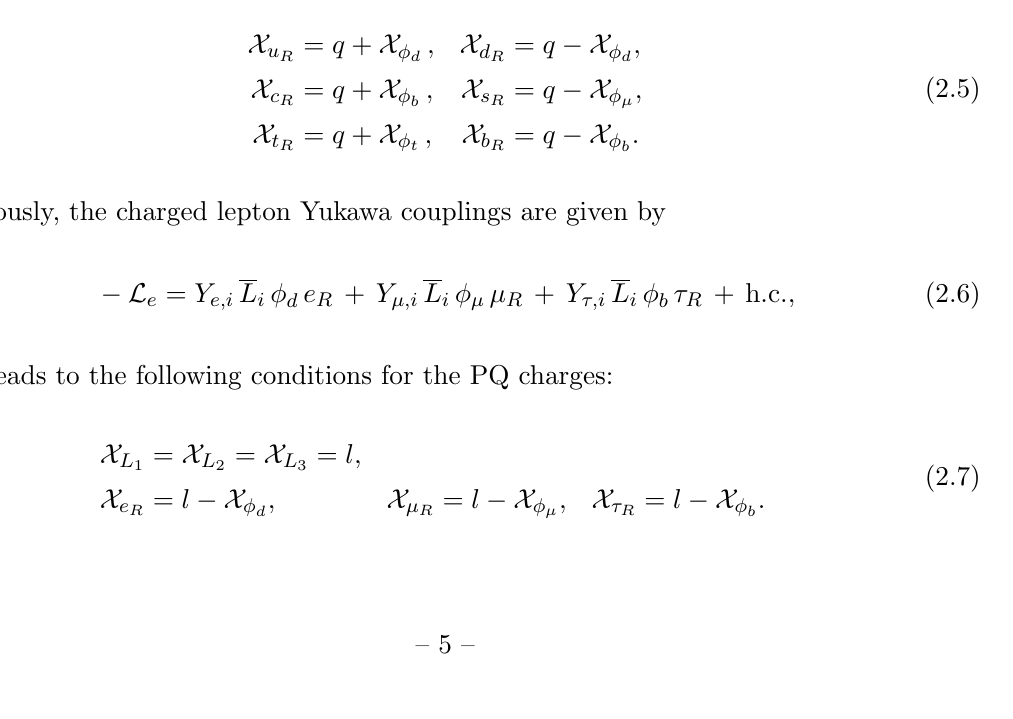
while for the right-handed quarks we